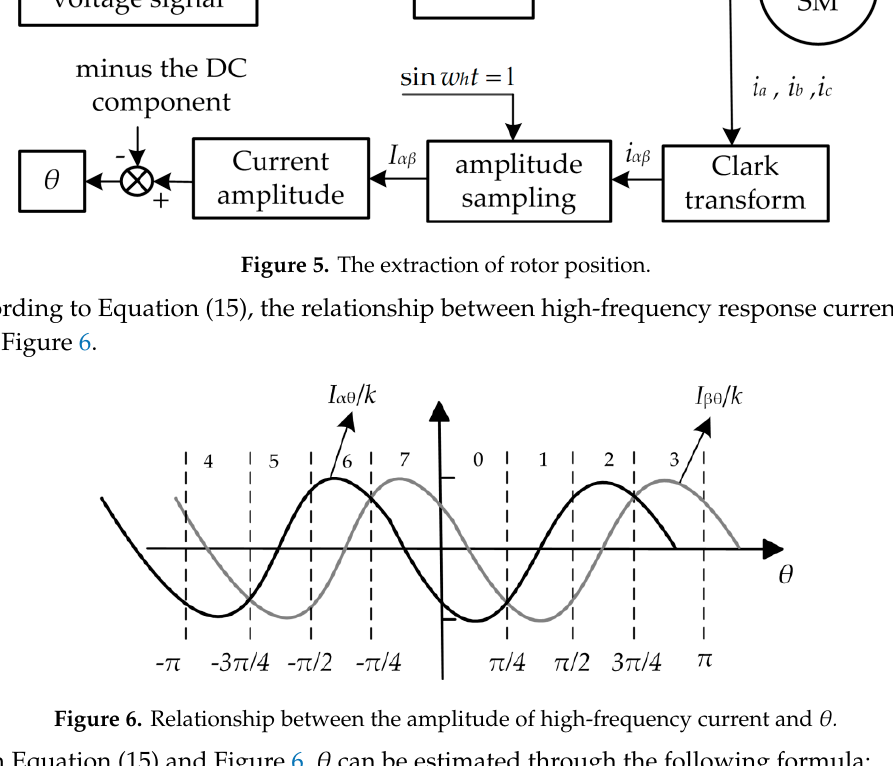
Figure 6. Relationship between the amplitude of high-frequency current and θ .